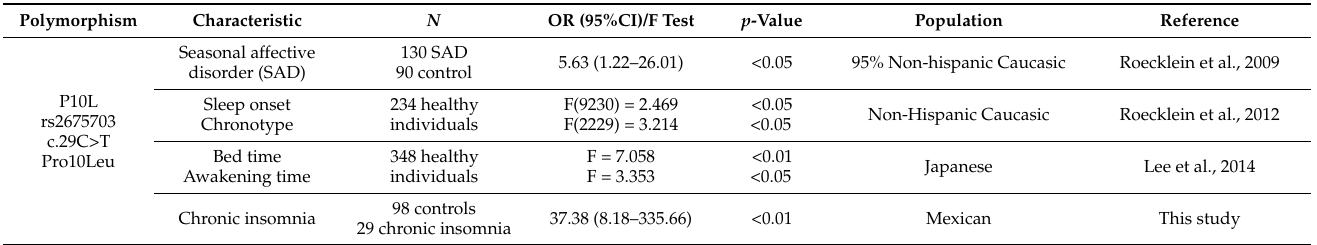
Table 4. Genetic contribution to P10L polymorphism melanopsin